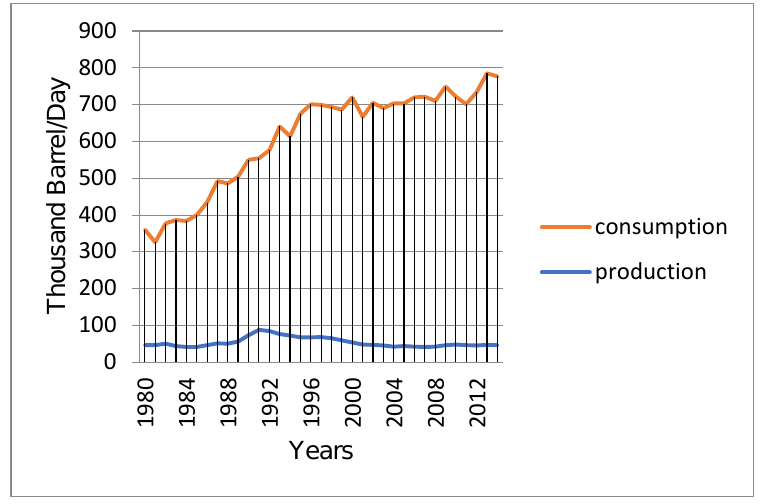
Figure 1. Oil consumption and production over the period 1980–2014 in Turkey. Source: Author’s own calculations.